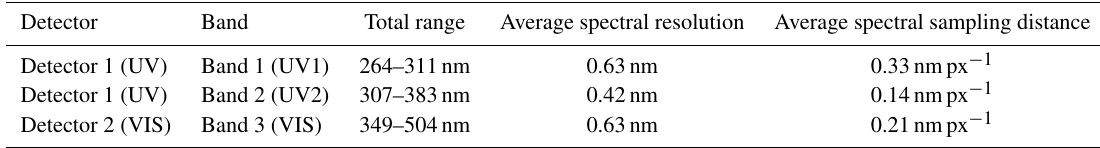
Table 1. Spectral range, resolution, and sampling distances of OMI. Bands 1 and 2 are imaged separately onto detector 1 to allow for different spatial sampling and higher signal-to-noise ratio in band 1.